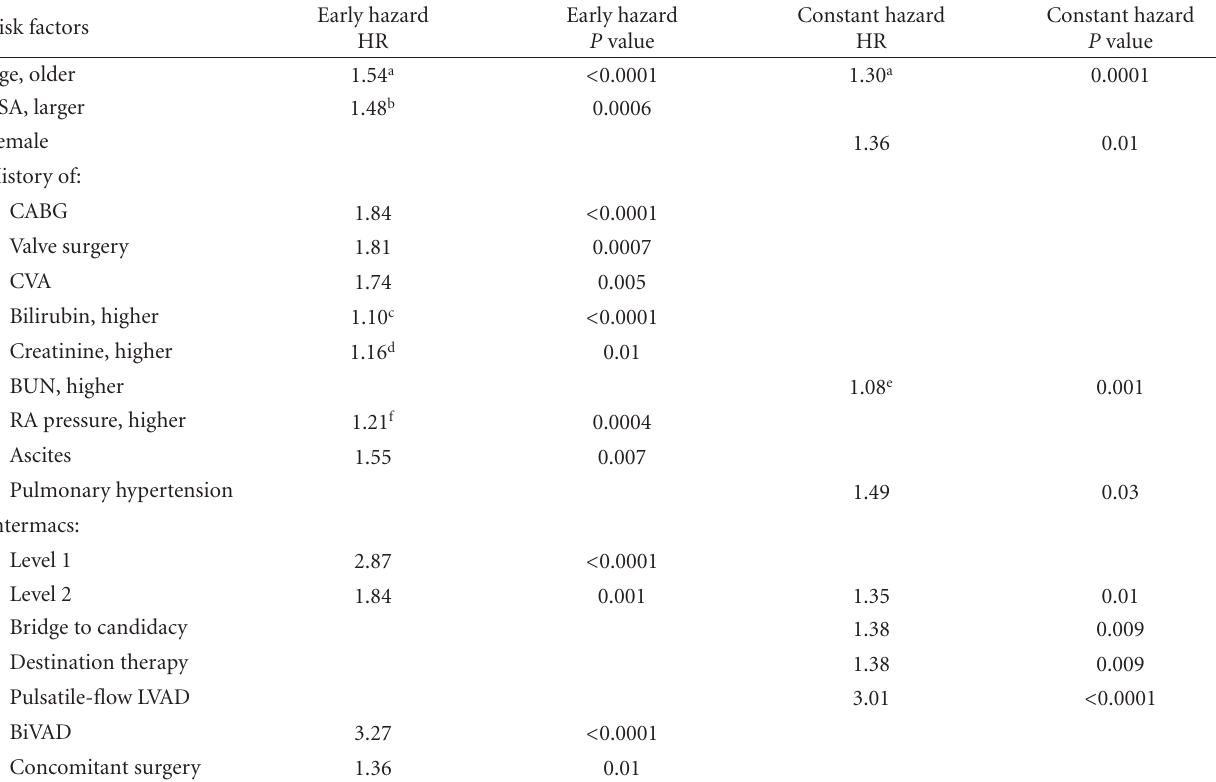
Table 4: Risk factors for death in 4,366 primary implant patients: 06/2006–06/2011 ( with permission from: The Fourth INTERMACS Annual Report)